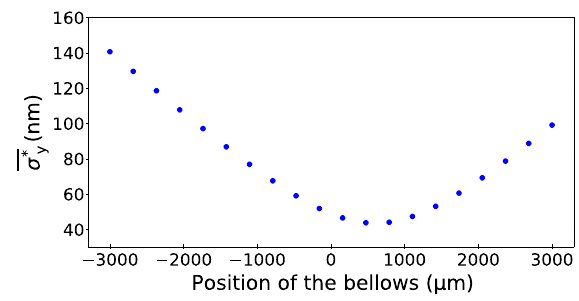
FIG. 12. Average vertical IP beam size ( σ (cid:1) y ) vs the position of the bellows, for one machine at 1 . 0 × 10 10 e −